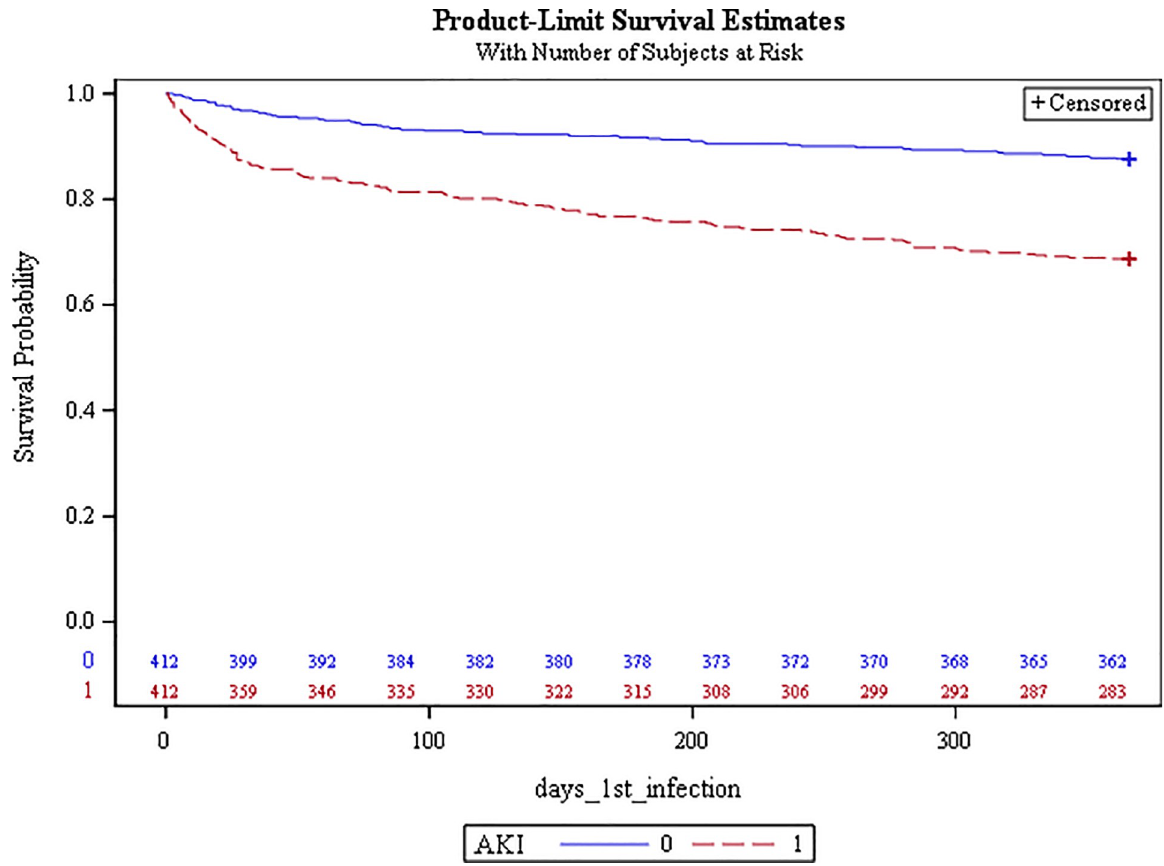
Fig 3. Survival curve for time to first infection among AKI cases (red) and controls (blue).